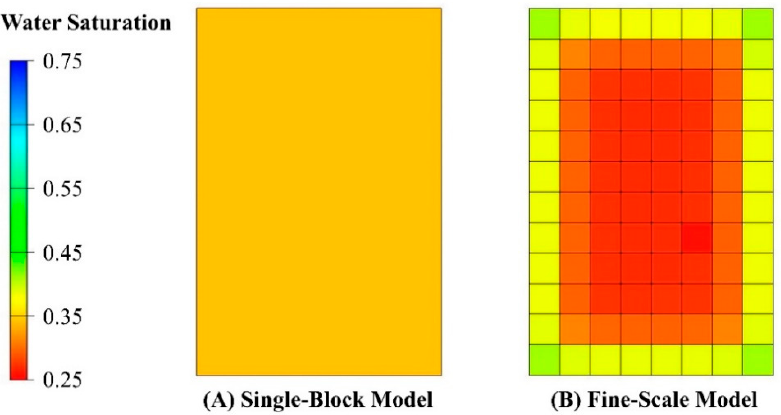
Figure 10. Water saturation profile in the matrix after 10 days of fluid exchange between the matrix and fractures ( A ) using the dual-porosity model for a single matrix block, and ( B ) using the single-porosity model for the same matrix block in ( A ) after discretisation. The corner grid cells in the fine-scale model have shown a higher water saturation compared to the remaining cells, as they have two faces in contact with fractures for fluid exchange.